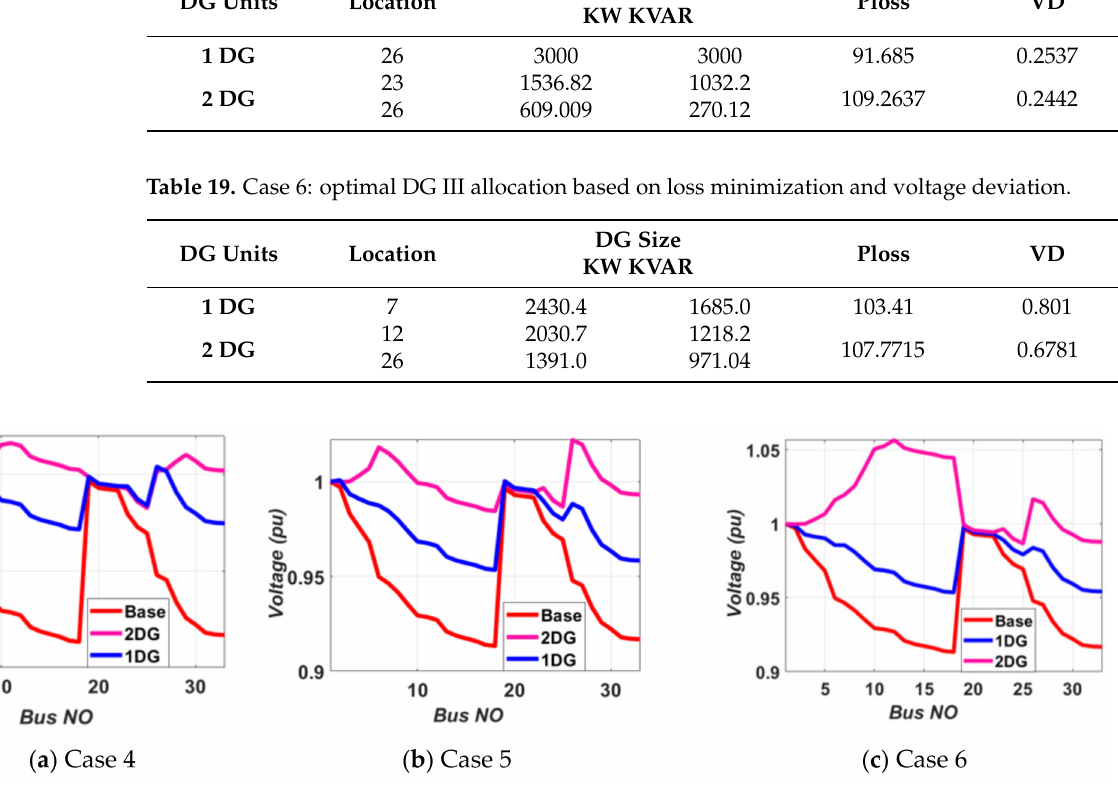
Figure 17. Voltage profile for IEEE 33-bus test system including multiple